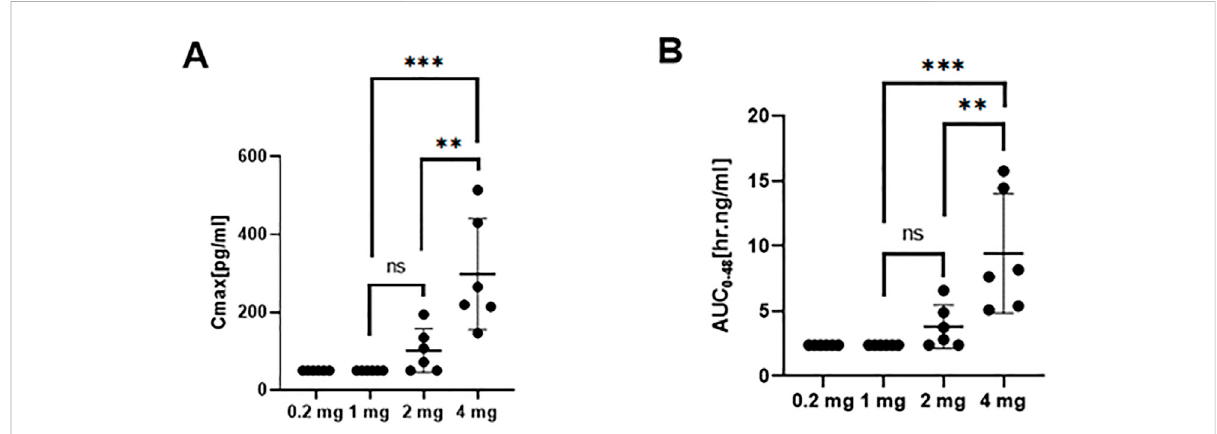
FIGURE 2 Pharmacokinetic pro fi le (mean ± SD) of TFF2-IFN in plasma in each group. (A) Cmax in plasma of each group. (B) AUC of each group. Abbreviations: Cmax, maximum concentration; AUC, area under the curve. The signi fi cant difference analysis was evaluated using one-way ANOVA with Tukey ’ s multiple comparison test (* p < 0.05, ** p < 0.01, *** p < 0.001, ns p > 0.05 non signi fi cant).